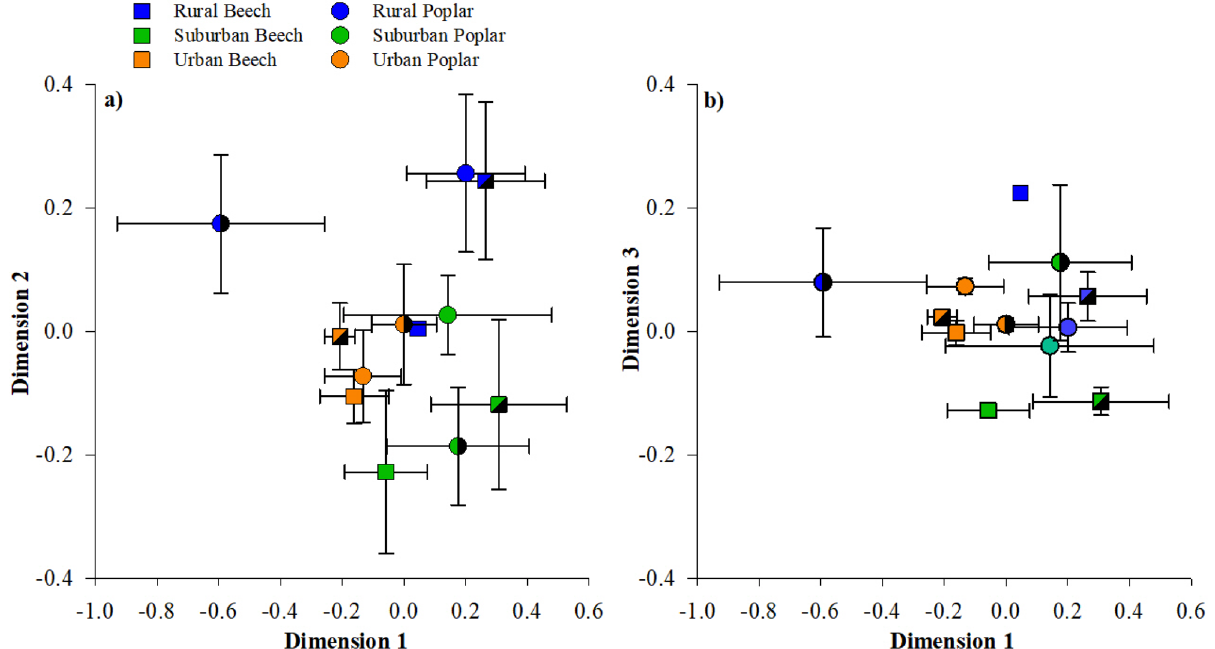
Figure 5. Nonmetric multidimensional scaling (NMDS) ordination comparing beech and yellow poplar microbial community (phyla level composition) across 3-forests (rural-suburban-urban; and 2-locations (Interior: open symbols vs. Edge: hashed symbols) across a) Dimension 1 and Dimension 2 and b) Dimension 1 and Dimension 3. Samples are color-coded to indicate the different forest types. Each point represents the average of three sampled trees (± standard error).